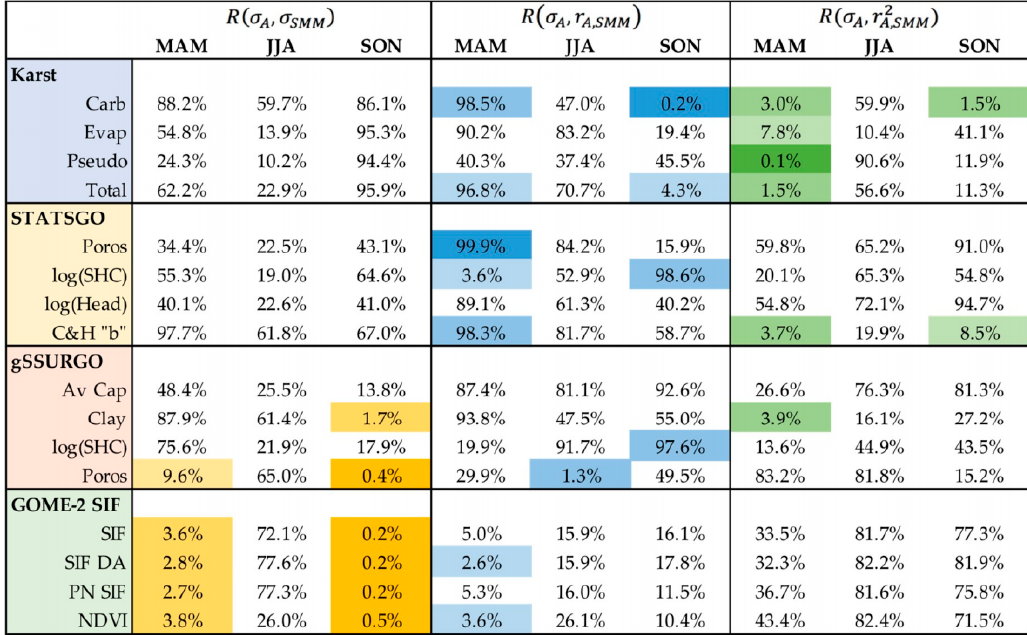
Figure 4. Nonparametric rankings as a function of season for the domain wide spatial correlations R between within-radius standard deviation of the properties A listed at the left and the indicated terms: standard deviation of SMM on the left (yellow highlights); correlation between A and SMM (center, blue highlights); explained variance between A and SMM (right, green highlights). Highlight shades progress from lighter to darker for significance thresholds of 10%, 5% and 1% as described in the text.